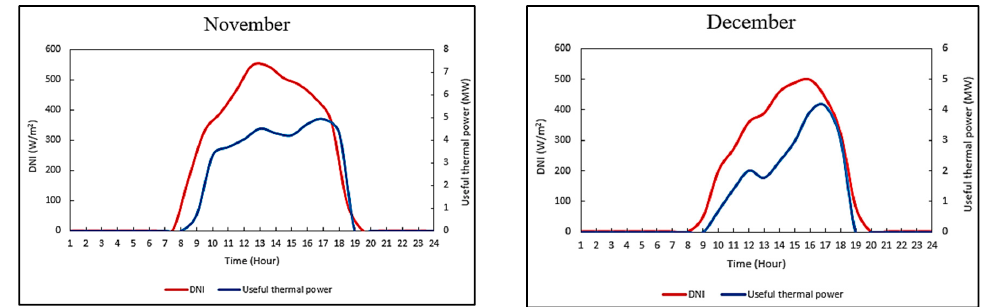
Processes 2018 , 6 , x FOR PEER REVIEW